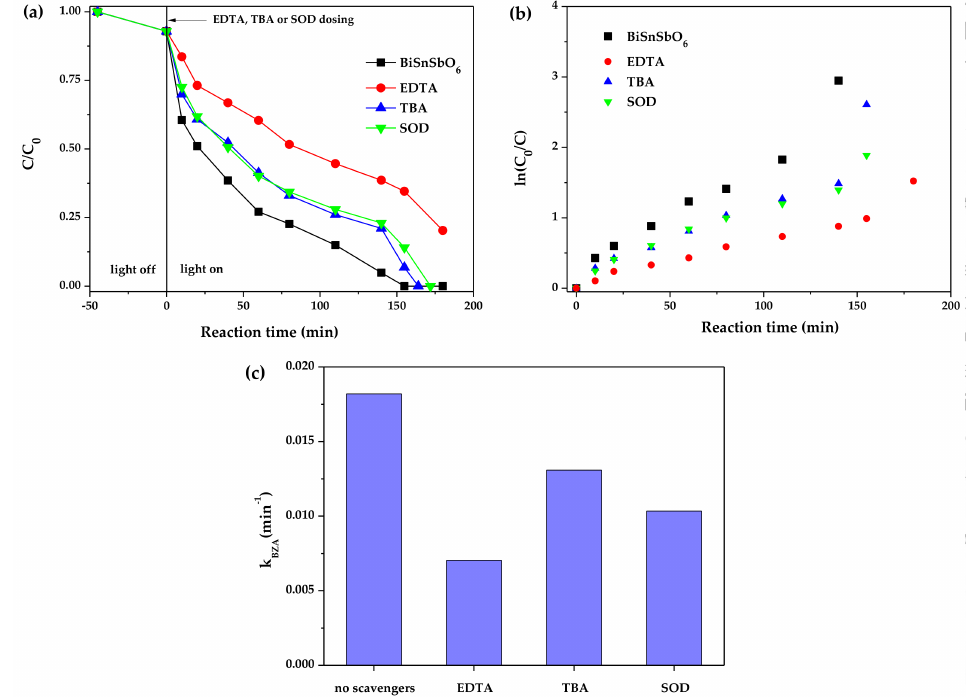
Figure 11. ( a ) Degradation of BZT over BiSnSbO 6 in the presence of different scavengers (1.5 mM, 2.5 vol% of reaction solution); ( b ) Linear relation plots of ln(C 0 /C) vs. reaction time; ( c ) The photodegradation rate constants ( k ) calculated from ( b